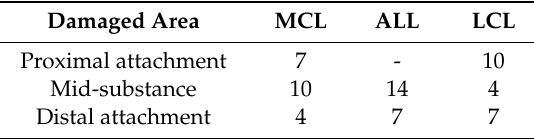
Table 4. Failure mode of the ligaments.